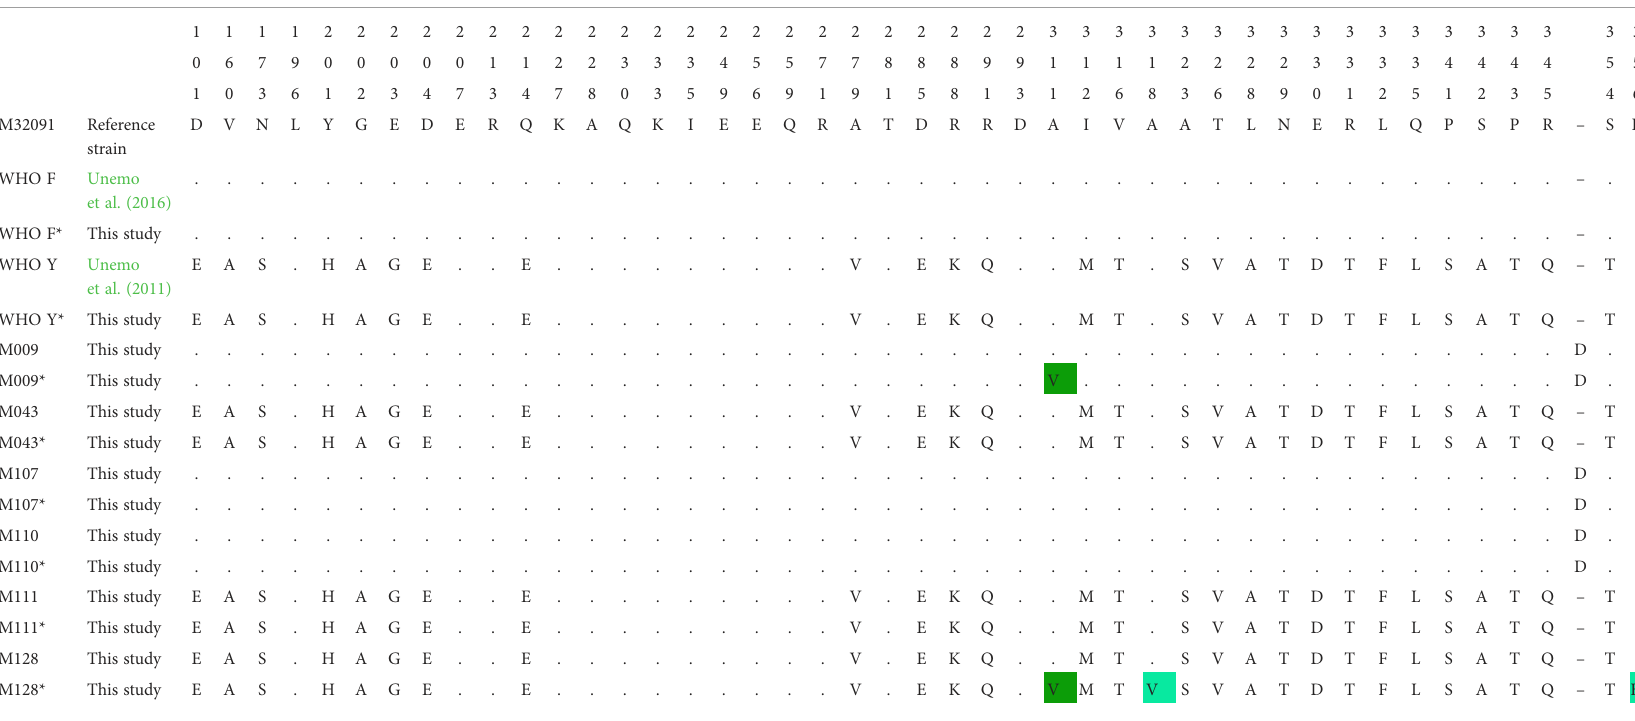
TABLE 3 Amino acid sequence alignment of penicillin-binding protein 2 of Neisseria gonorrhoeae isolates before and after selection for resistance to ce fi xime. Amino Acid Position According to the Reference Strain